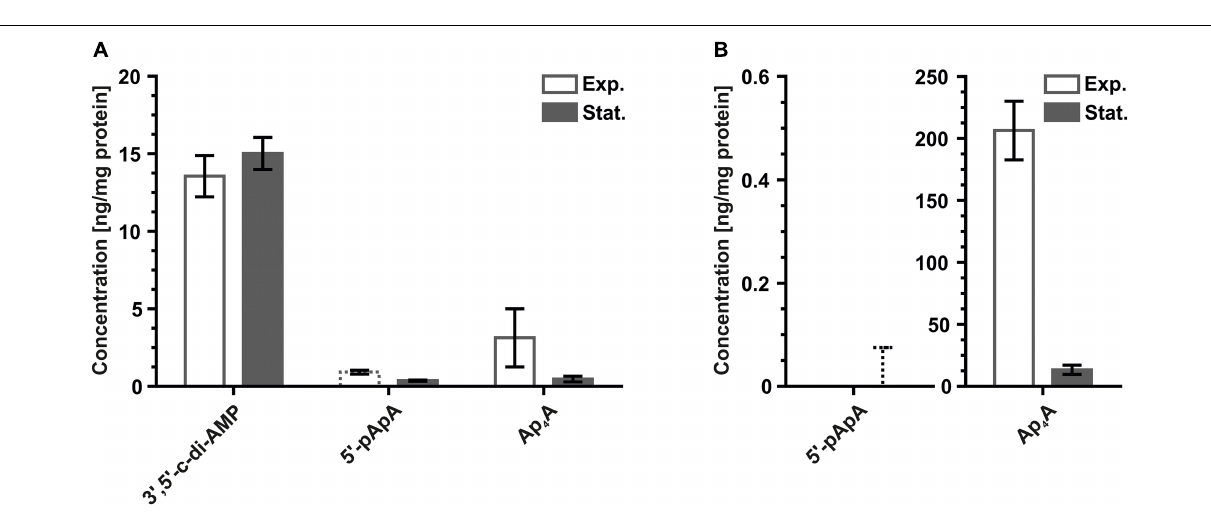
FIGURE 3 | Levels of di-nucleotide-based (putative) second messengers detected for exponentially and stationary growing (A) H. volcanii H26 and (B) S. acidocaldarius MW001 cells normalized to the protein content of each sample. Values of regular columns represent the mean of three biological replicates. Error bars of regular columns indicate standard deviation of three biological replicates. Dashed columns indicate presence of one or more technical replicates with measured nucleotide levels below the lowest limit of quantification (LLOQ). Values of dashed columns represent the mean of all technical replicates with nucleotide levels ≥ LLOQ. Error bars of dashed columns indicate standard deviation of all technical replicates with nucleotide levels ≥ LLOQ. Dashed error bars indicate absence of a single technical replicate with measured nucleotide levels ≥ LLOQ. Values of dashed error bars represent the highest calculated value of all analyzed technical replicates with measured nucleotide levels < LLOQ. The exact nucleotide concentrations are summarized in Table 3 (Exp., exponential; Stat.,